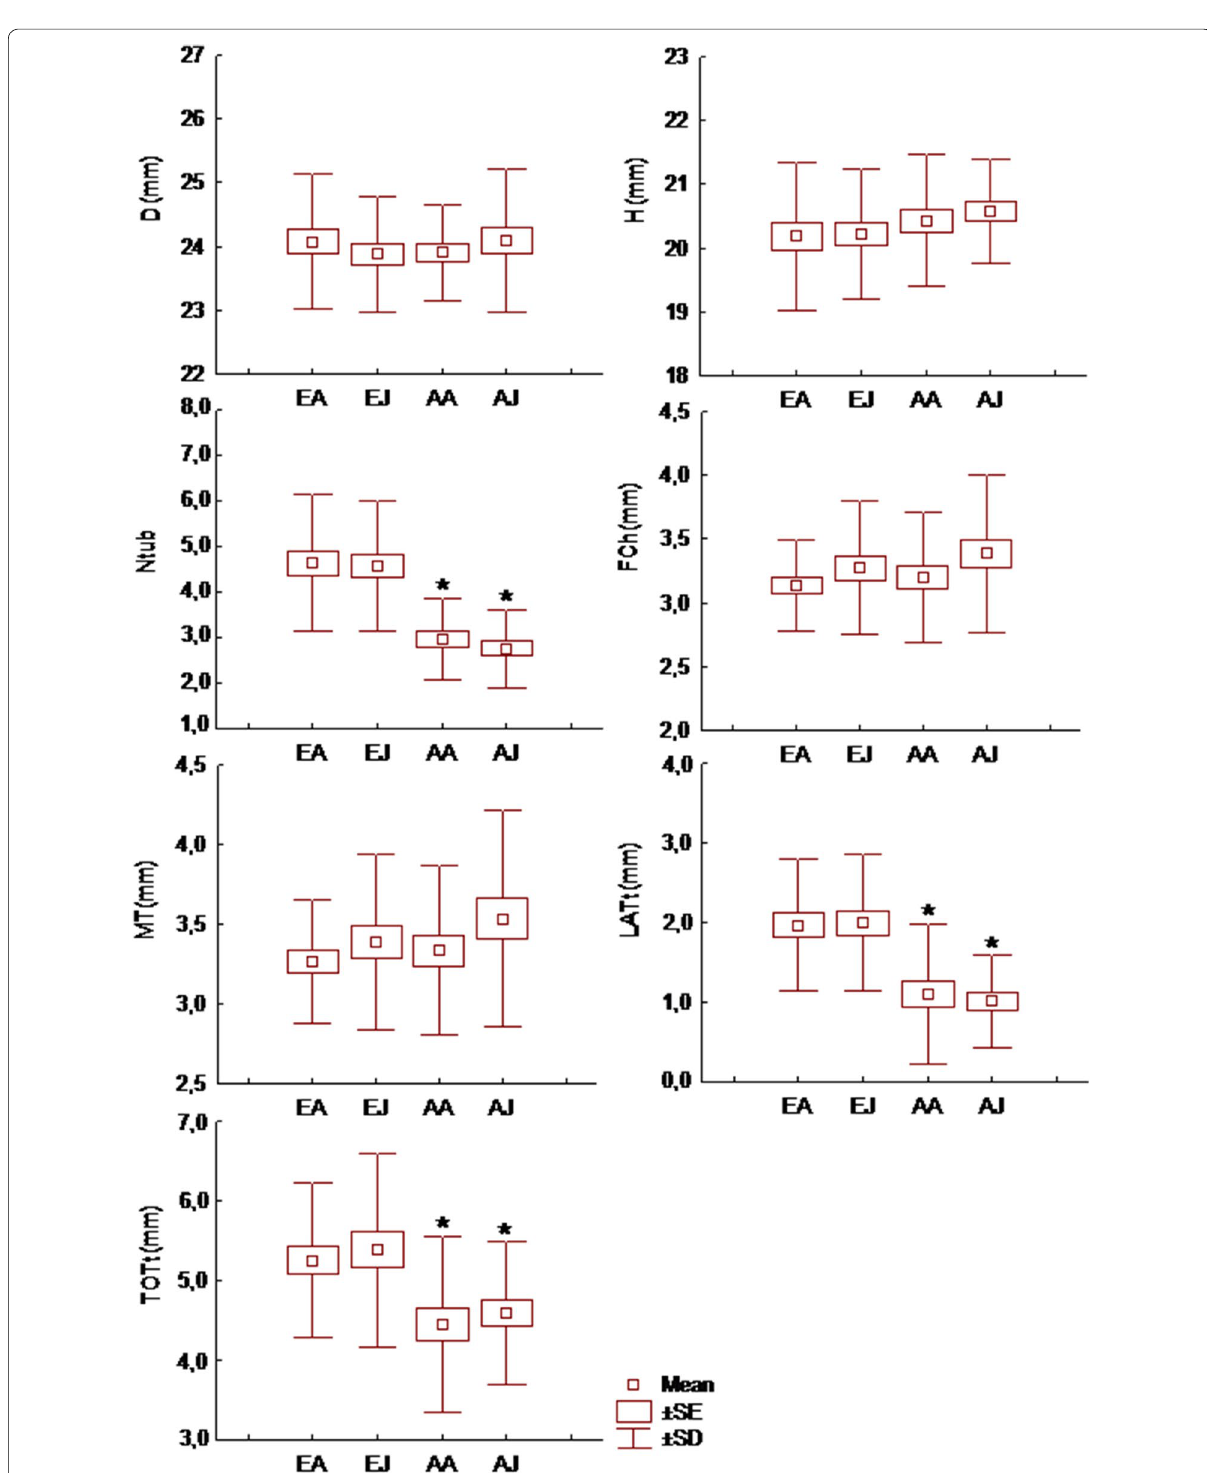
Fig. 2 Comparison of shell size and morphological characteristics of the FPSC of Cepaea vindobonensis between samples taken from the two study sites. D: shell diameter, H: shell height, Ntub: number of spermathecal tubules, F.Ch.: length of the fertilization chamber, M.T.: length of the main tubule, LAT.t: the cumulative length of lateral tubules, TOT.t: the cumulative length of all tubules. EA: Edessa-April, EJ: Edessa-June, AA: Axios-April, AJ: Axios-June. Asterisks indicate significant differences at p <